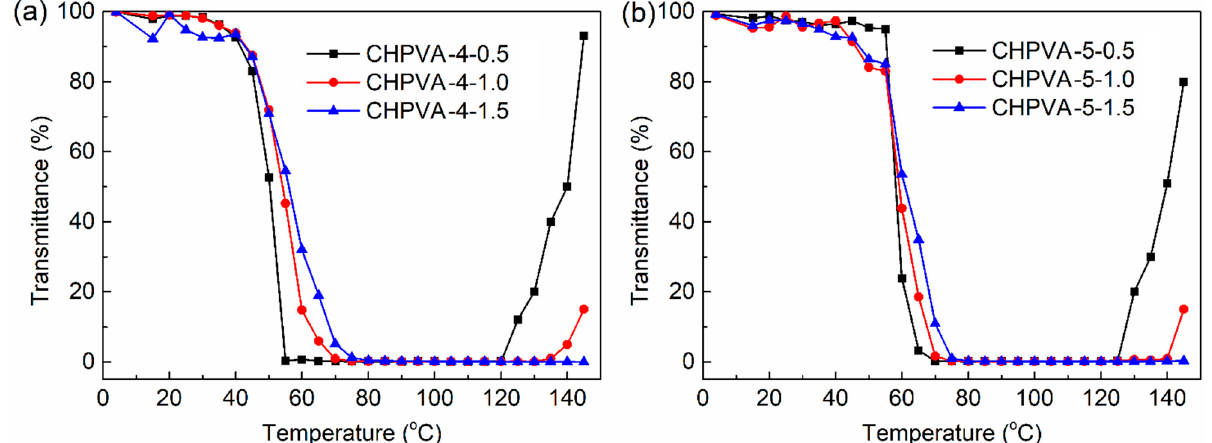
Figure 7. Changes in transmittance with temperature for chemically crosslinked CHPVA hydrogels modified by ( a ) 4% of HPM and ( b ) 5% of HPM with different crosslink densities (0.5, 1.0, and 1.5 wt.%). Changes in transmittance were recorded during heating at 10 ◦ C/h.